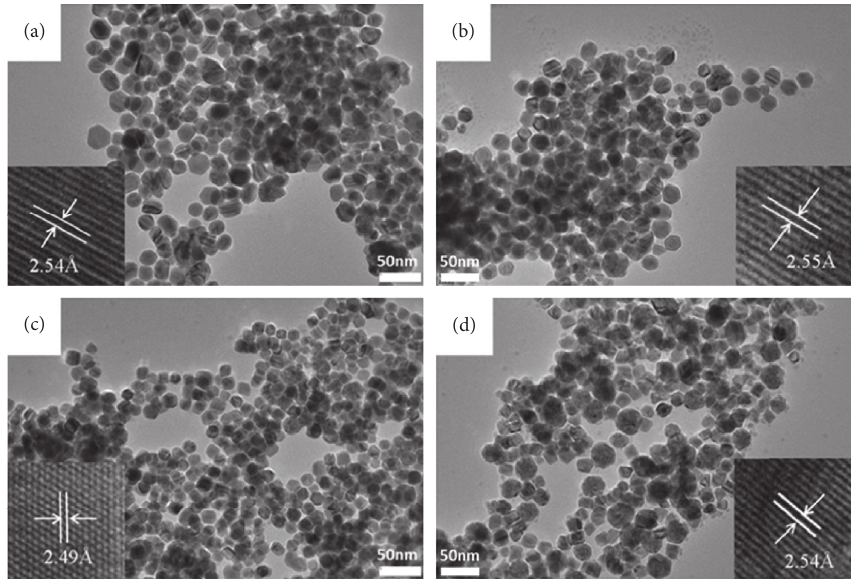
Figure 3: TEM and HRTEM images of PdAg-acac-1 (a), PdAg-acac-2 (b), PdAg-acac-4 (c), and PdAg-acac-5